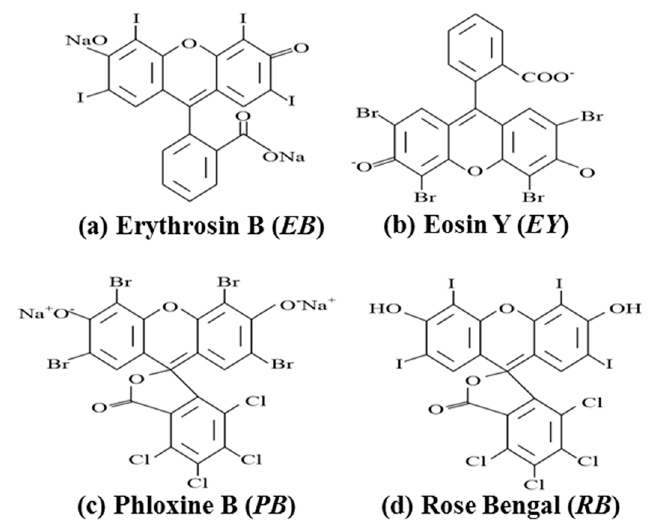
Figure 1. Structural formulas for four different photosensitizers.